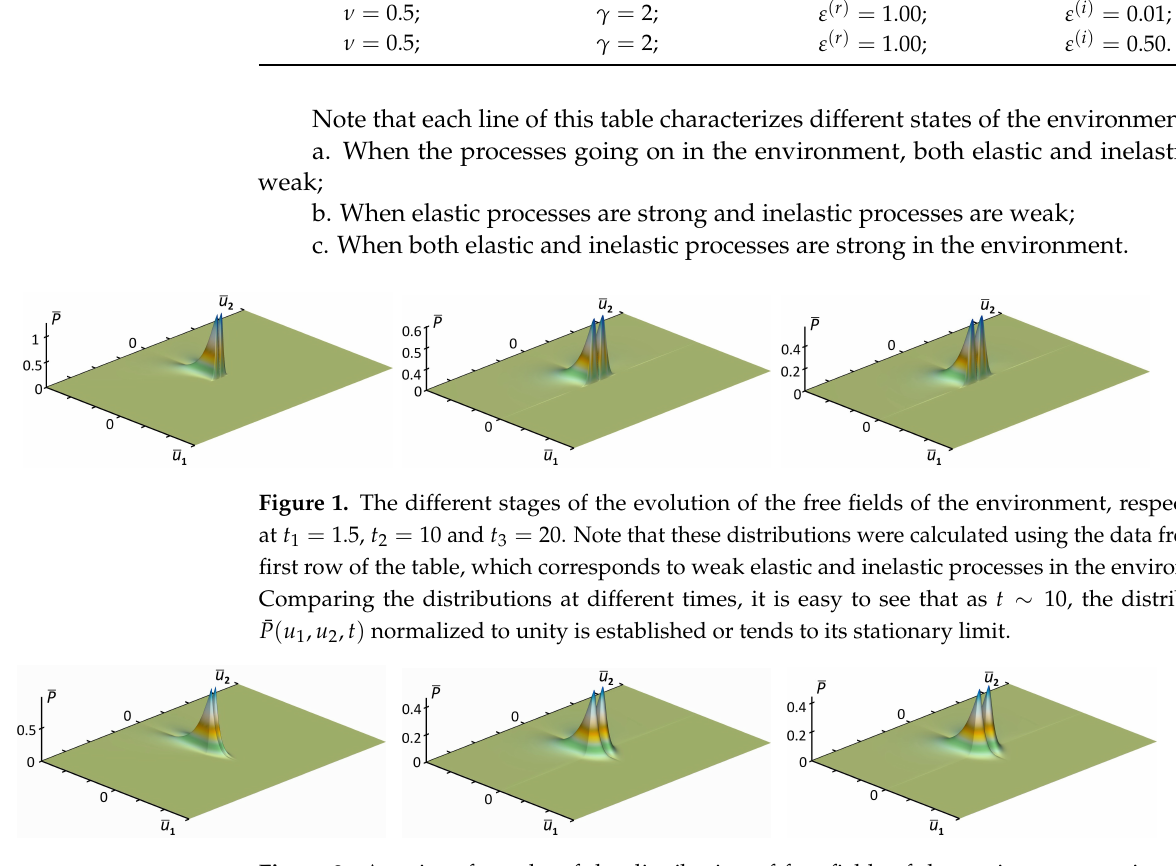
Figure 2. A series of graphs of the distribution of free fields of the environment at time points t 1 = 1.5, t 2 = 10, t 3 = 20. Recall that we used the data of the second line table, which characterizes strongly elastic and weakly inelastic processes occurring in the environment. An analysis of the graphs shows that the distribution tends to the stationary limit already at t ∼ 7.